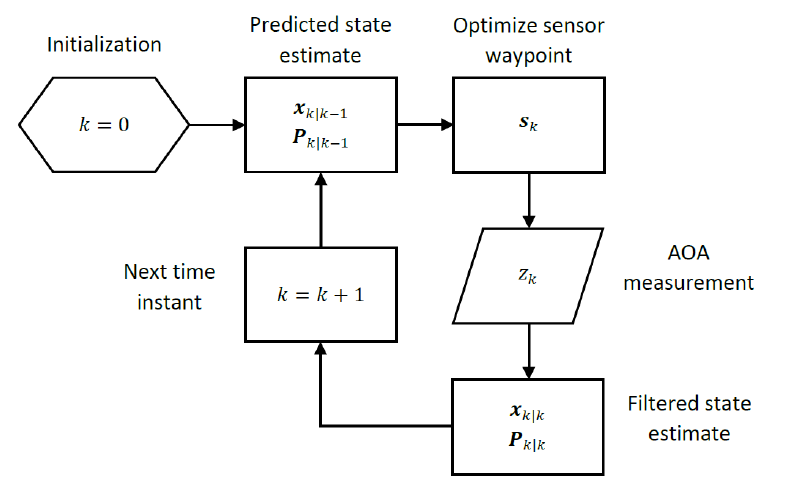
Figure 4. Optimal sensor waypoint computation in a Kalman filter